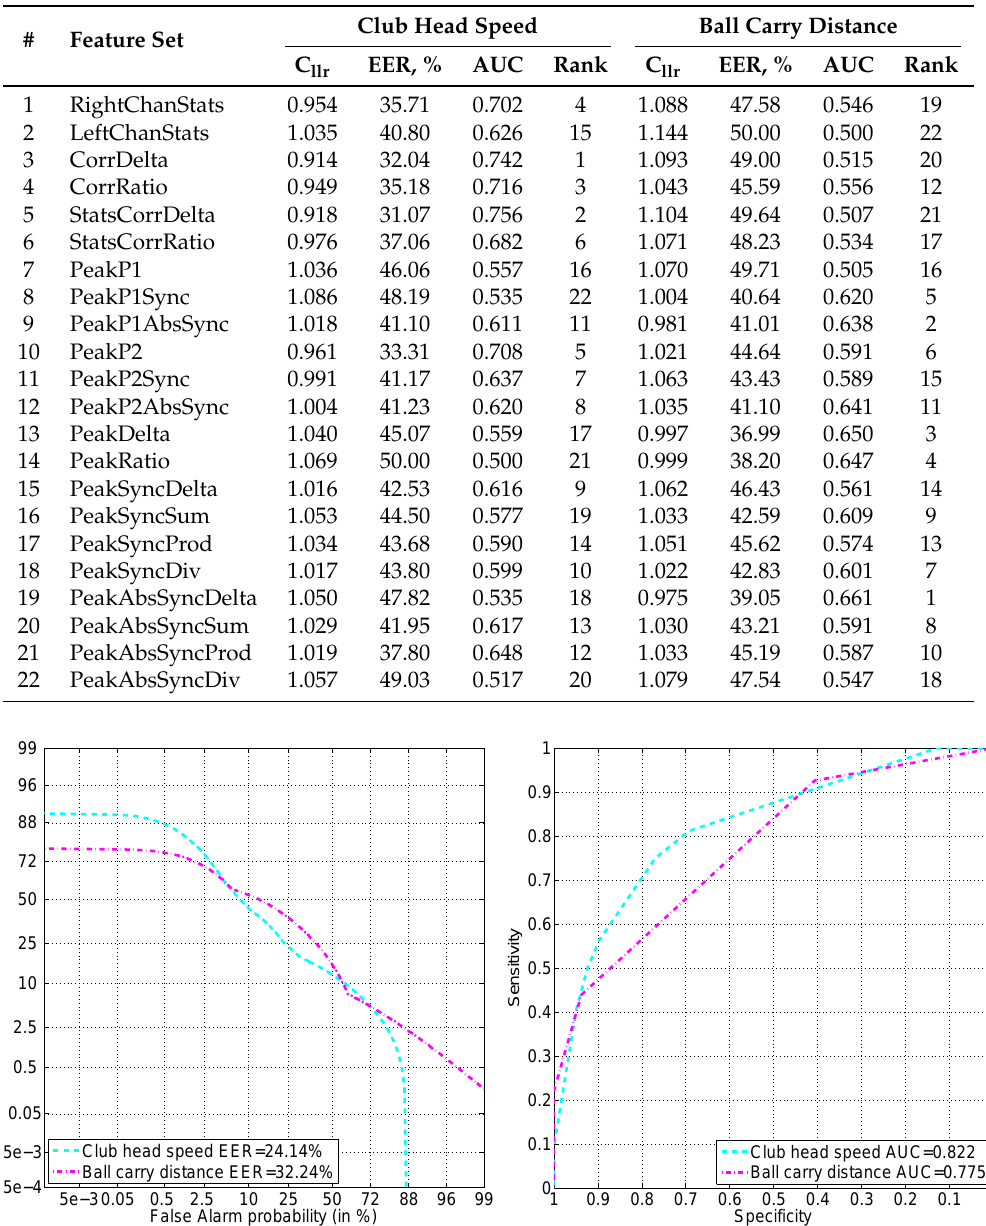
Figure 8. Decision-level fusion for detection task: evaluation by the detection error trade-off (DET) ( Left ) and ROC ( Right )